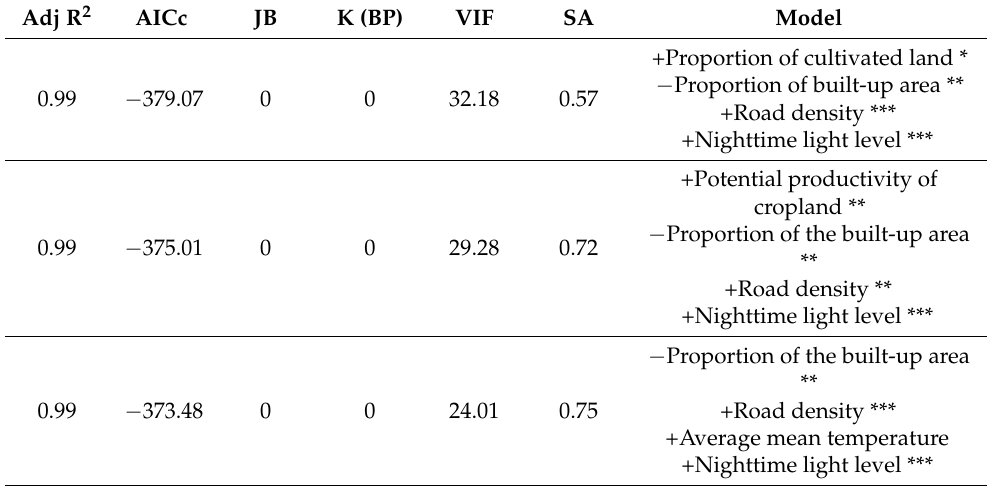
Table A2. The highest adjusted R 2 results of the explanatory regression analysis of the SPLIT and four independent variables.